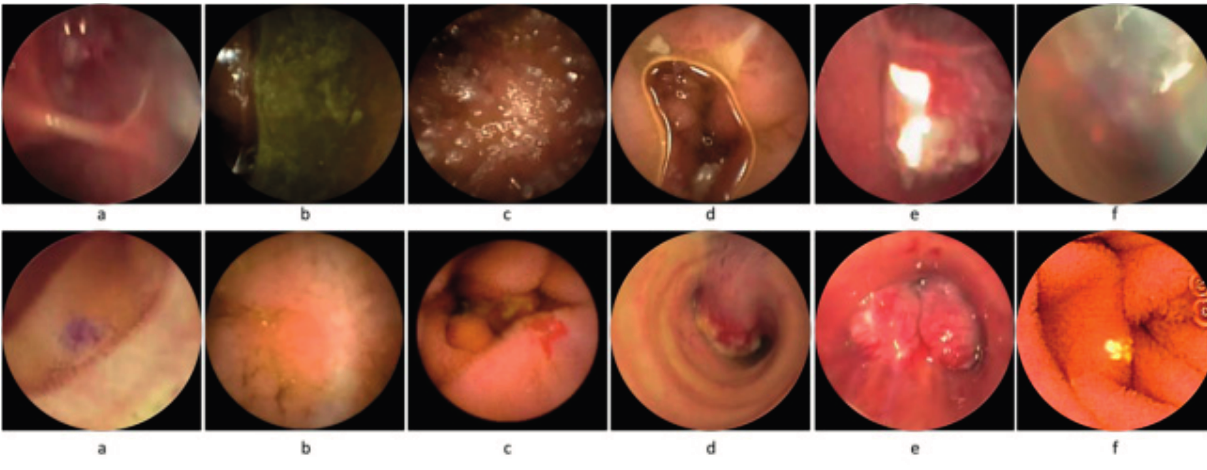
Figure 5. Sample frames from WCE videos: first row shows example of non-informative frames and second row shows informative